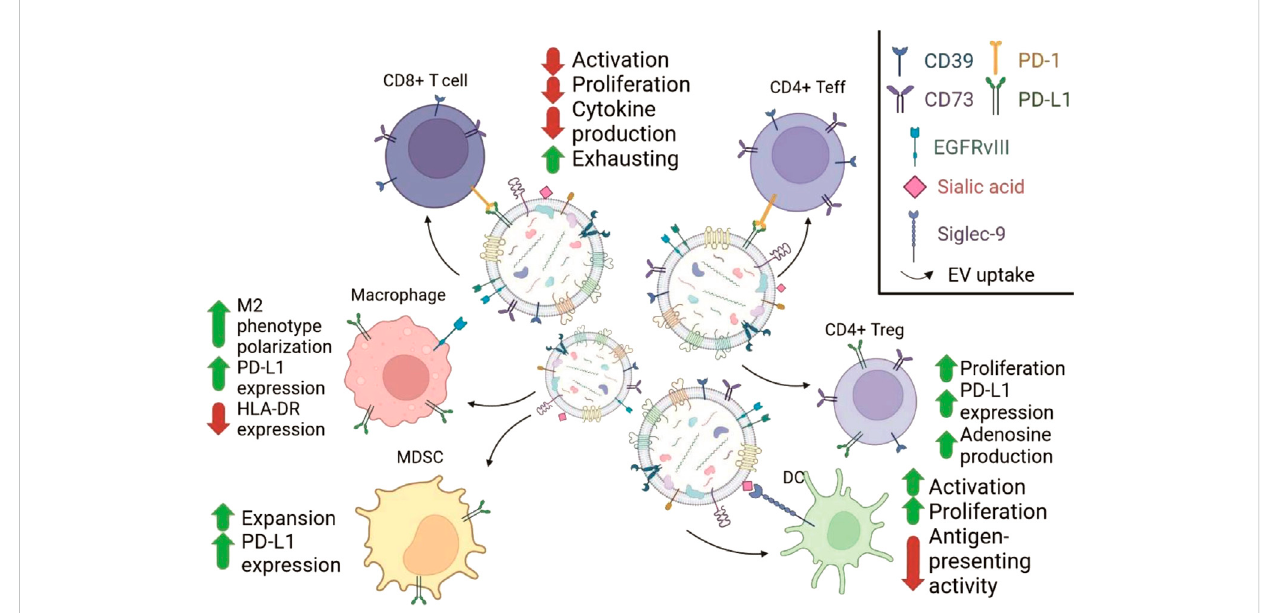
FIGURE 3 Schematic representation of GBM-EVs effects on the immune cells mediated by the surface molecules. GBM-EVs (in the middle) carry molecules participatingin ligand-receptor interactions with molecules on thesurfaceof immune cells (adopted with modi fi cations fromScholl etal., 2020; Ricklefs et al., 2016; Jung et al., 2022; Dusoswa et al., 2019). The changes in immune cells are indicated with arrows with supporting text. Chart in the upper right corner explains the symbols used to show different membrane proteins from